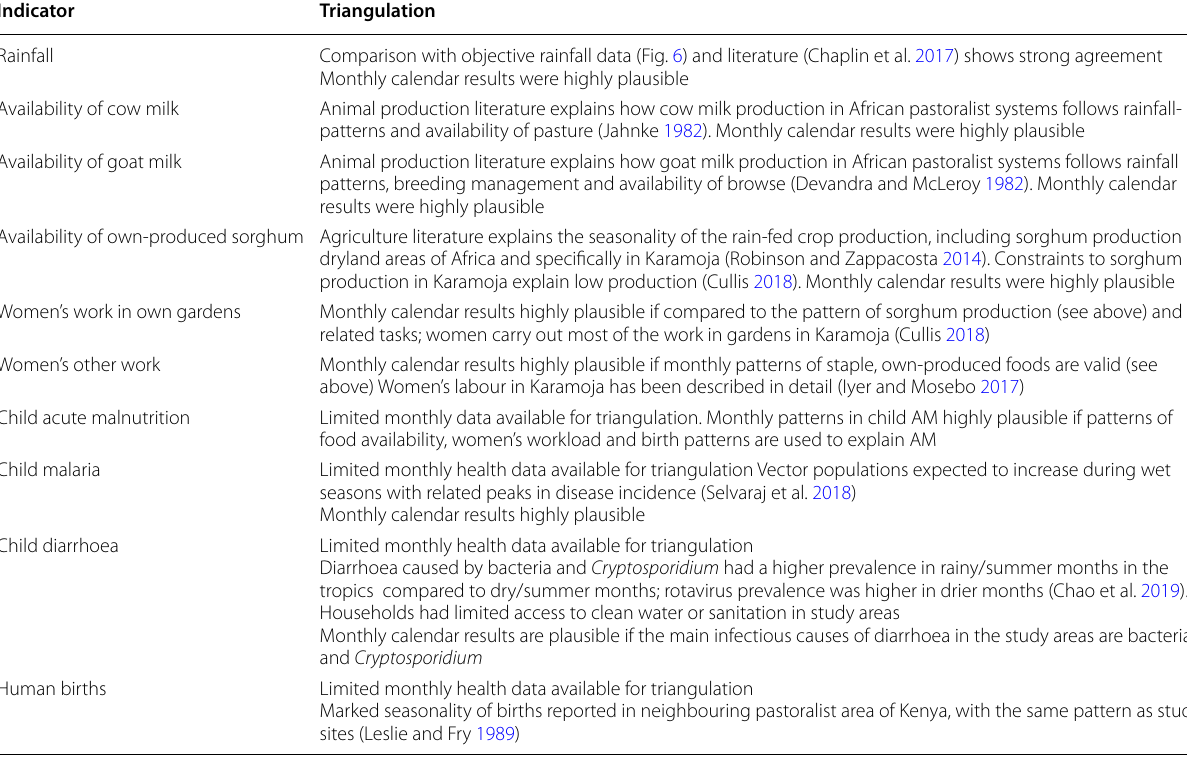
Table 2 Triangulation of monthly calendar results and assessment of technical plausibility Indicator Triangulation Rainfall